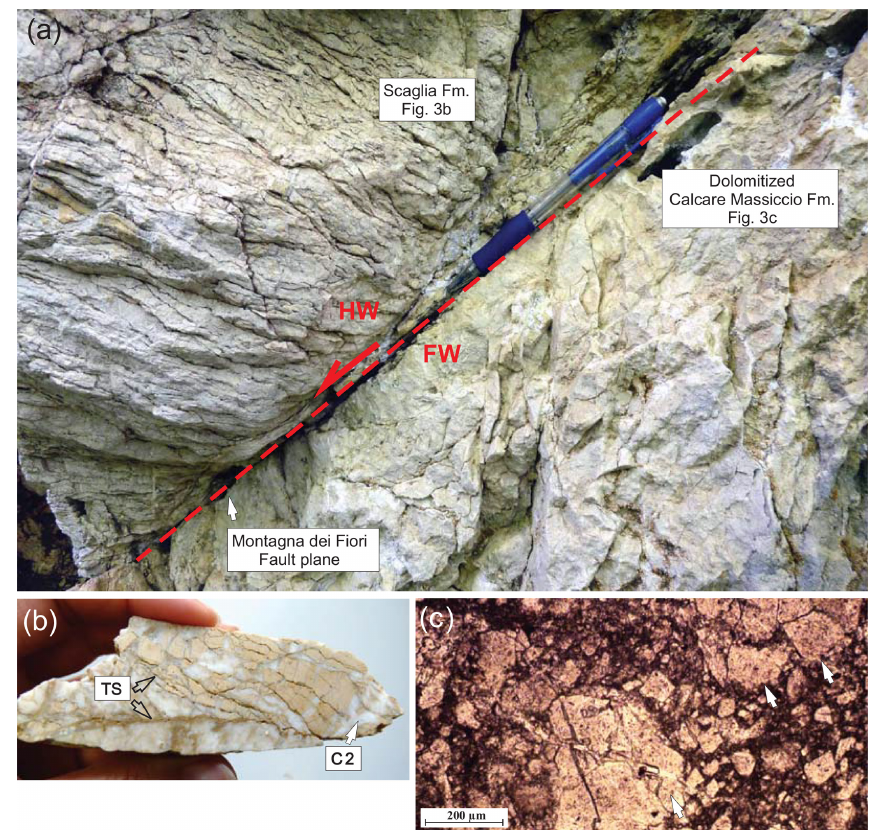
Figure 3. (a) Field photograph showing the deformed Scaglia Formation in the hanging wall (HW) and brecciated, dolomitized Calcare Massiccio Formation in the footwall (FW) of the Montagna dei Fiori Fault. The red arrow indicates the sense of fault movement. (b) A hand specimen from the deformed Scaglia Formation showing abundant pressure solution seems (TS), indicated by arrows, cross-cutting calcite veins (C2). (c) A transmitted light photomicrograph of the dolomitized, brecciated Calcare Massiccio Formation. Note all the breccia fragments are composed of dolomite (D4